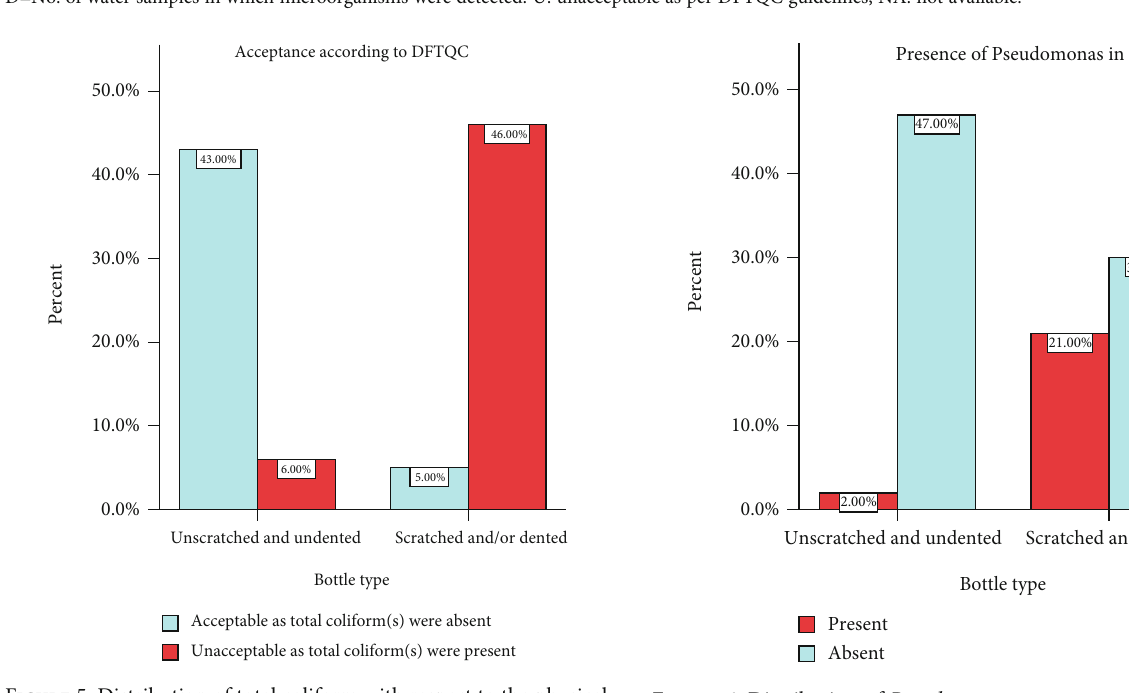
Figure 6: Distribution of Pseudomonas spp. count with respect to the physical condition of the bottled water